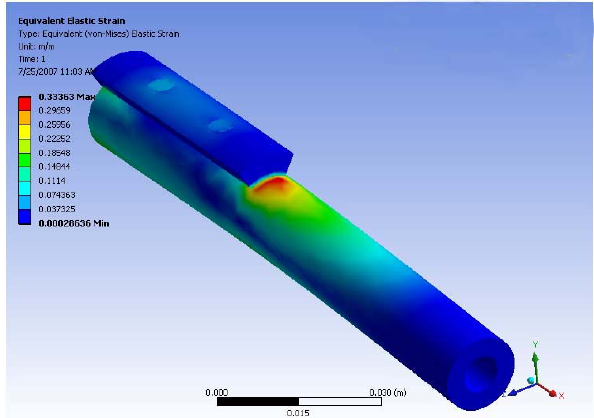
Fig.22 Parametric model equivalent